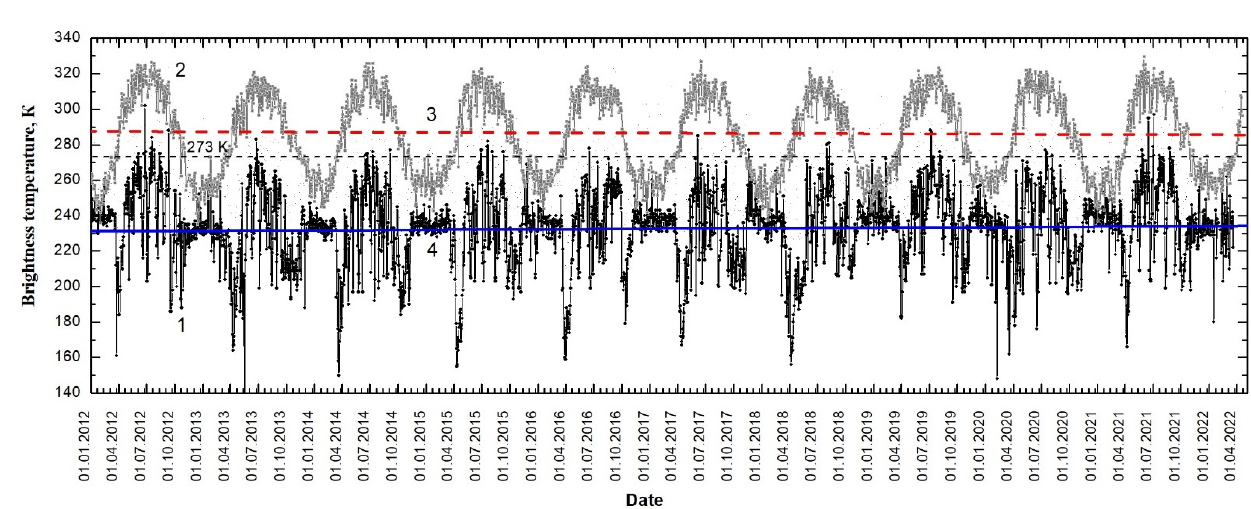
Figure 4. Dynamics of radio brightness and physical temperatures of the underlying surface in pixel 4,010,460 discrete geodetic grid DGG ISEA 4H9: 1—T BH ; 2—T; 3—T(D); 4—T BH (D).